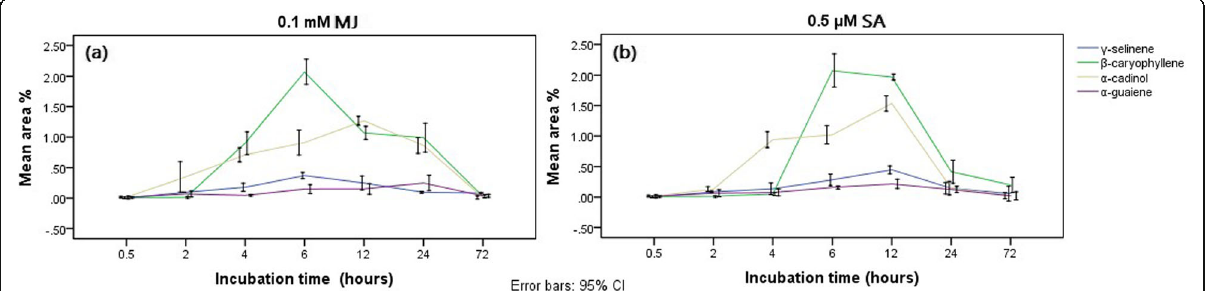
Fig. 5 Mean area percentages of sesquiterpenes produced in G. walla cell suspension under ( a ) MJ and ( b )